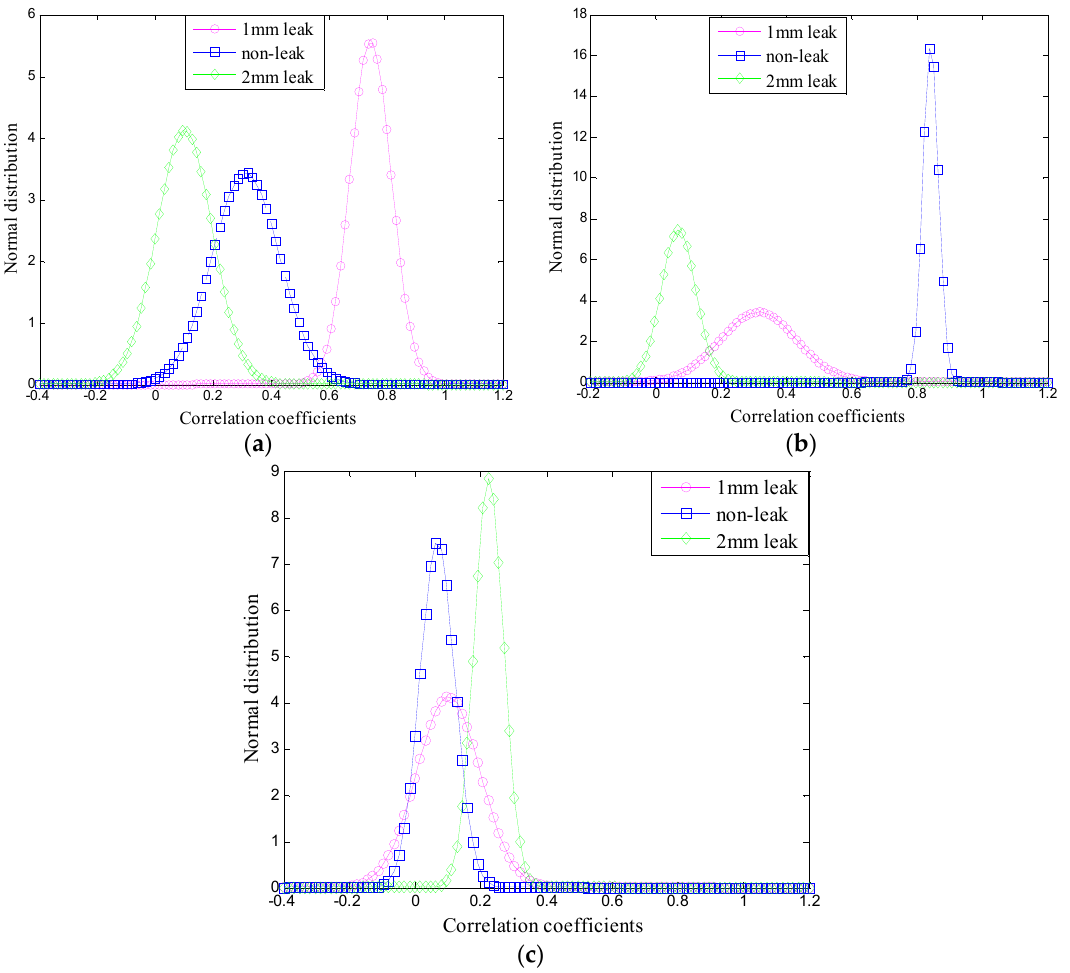
Figure 11. Normal distribution curves based on VMD: ( a ) for 1# case; ( b ) for 2# case; and ( c ) for 3# case.